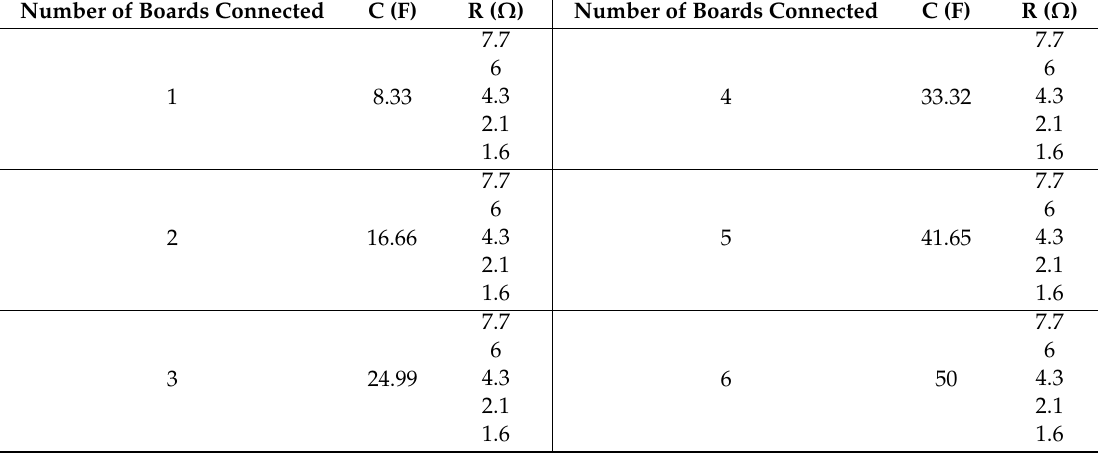
Figure 13. Results for charging ( a ) and discharging ( b ). Table 9. Information of the tests performed in the ultracapacitor test bench.